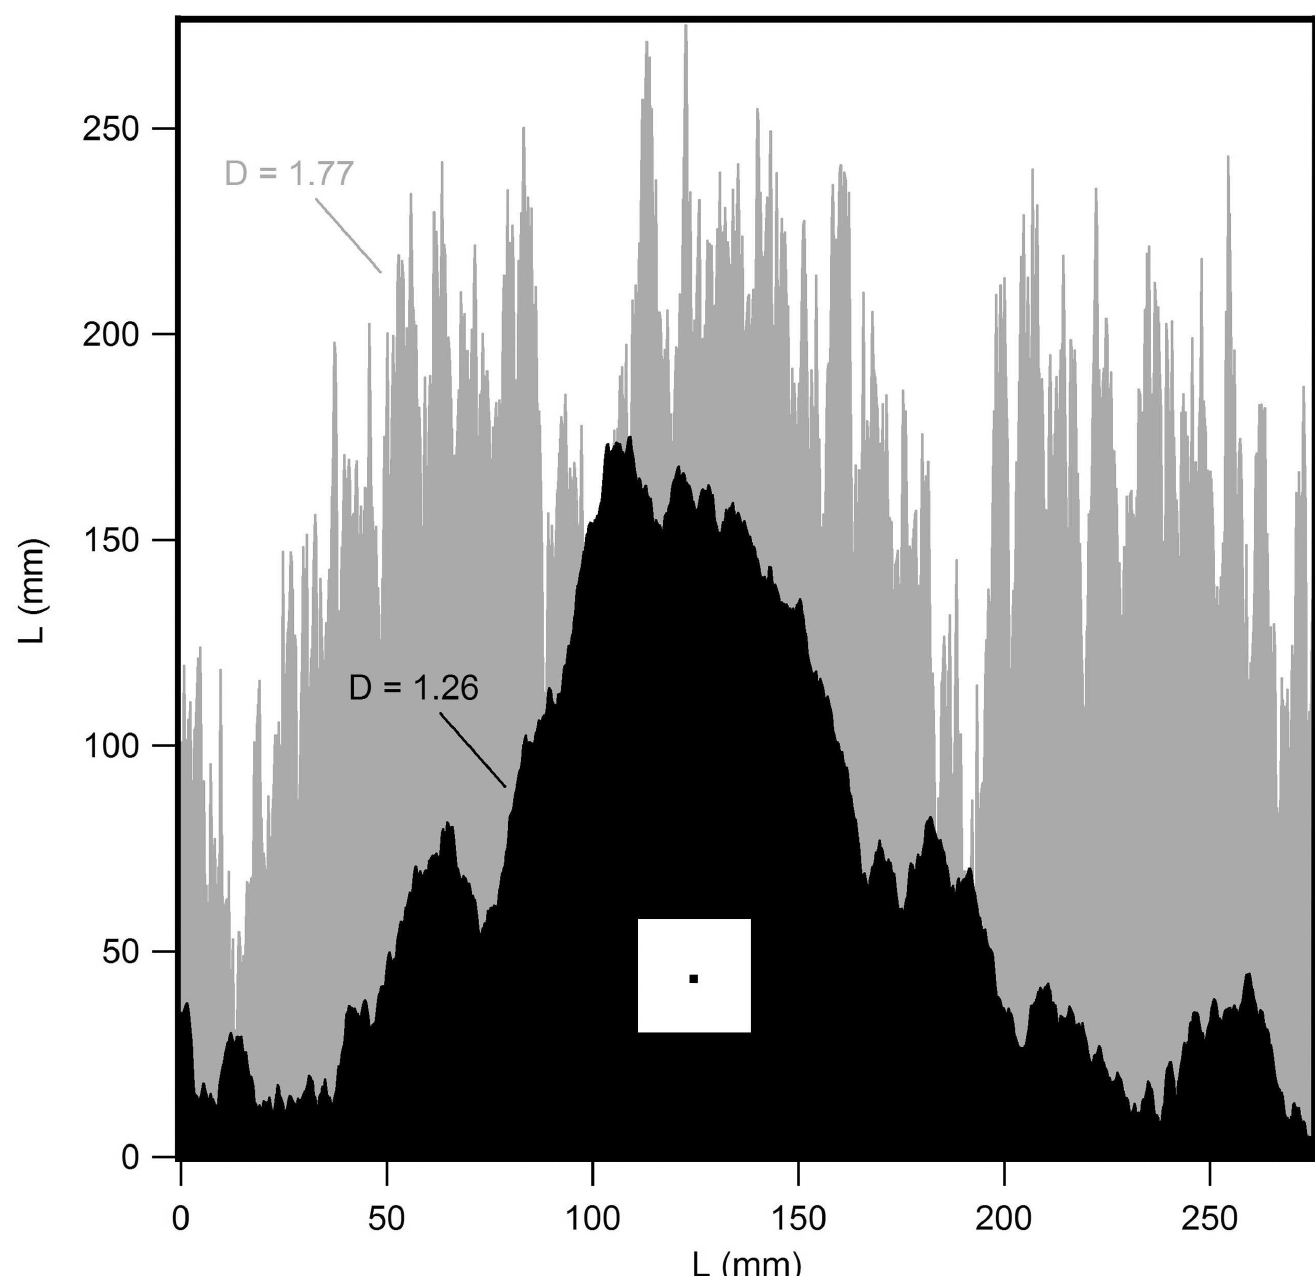
Fig 4. Computer-generated fractal boundaries. The black pattern has a D value of 1.26 that closely matches that of RorschachBlot Five, whilethe grey pattern has a much higher D value of 1.77. The black and white squaresindicate the smallest and largest box sizes used in the fractal analysisof these